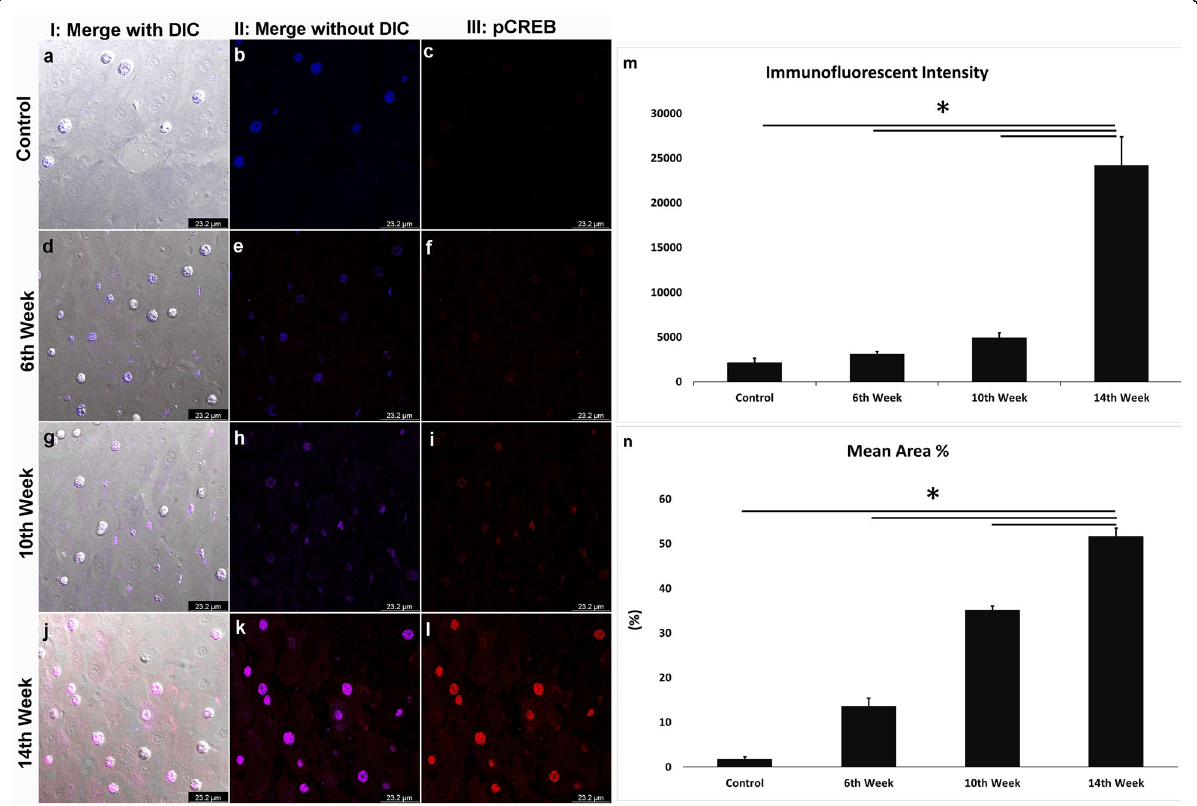
Fig. 4 a – l A photomicrograph of confocal image of liver specimens from NAFLD rats on sequential time intervals of high fat diet induction, revealing the progressive increase in the immunofluorescence intensity of pCREB (I, Hoechst + pCREB + DIC; II, Hoechst + pCREB; III, pCREB). m , n The significant increase in intensity and the mean area percent of immunostain of pCREB especially at the end of induction (14th week*; mean ±